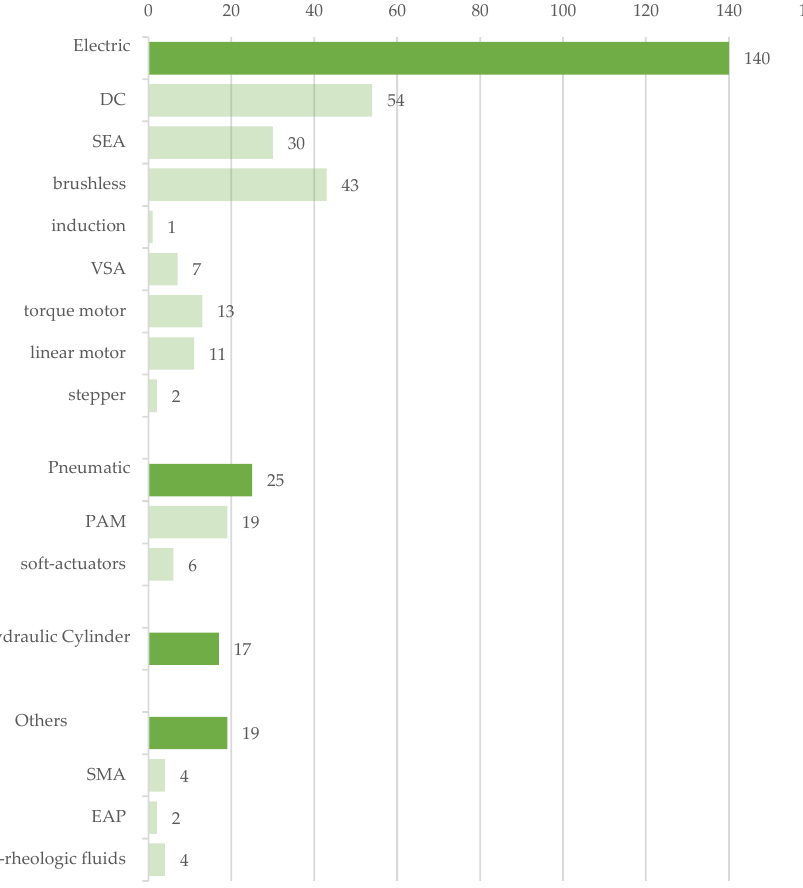
Figure 17. The distribution of exoskeletons by actuation technology. Among the electric solutions, brushed and brushless DC motors are the most used (39% and 31%, respectively). SEAs are also quite widespread (22%). Pneumatic solutions are mainly developed with